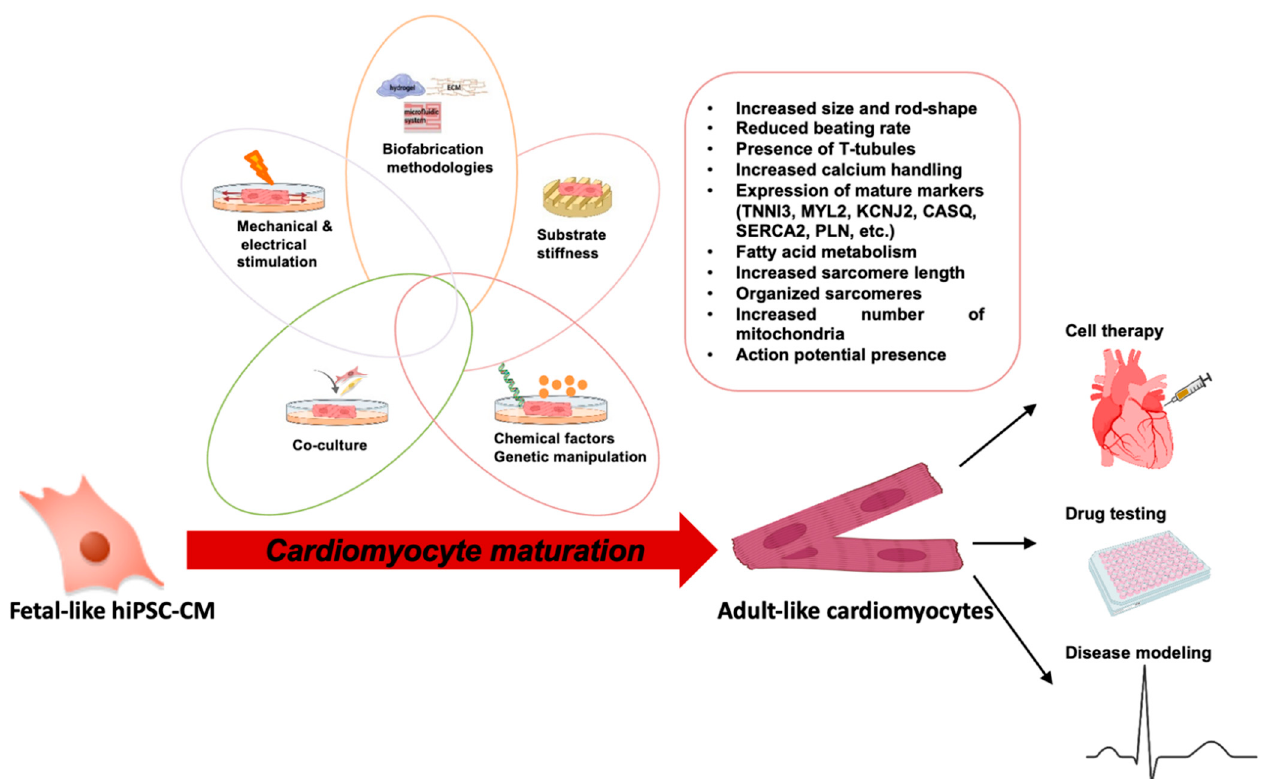
Figure 2. Strategies to increase maturation of hiPSC-CMs and their applications in basic research and in the clinical scenario. Electrical, mechanical, and biochemical factors, alongside genetic modifications and approaches aiming at adjusting substrate stiffness can be harnessed to enhance the maturation of hiPSC-CMs. Adult-like hiPSC-CMs are characterized by morphological, structural, genetic, and electrophysiological modifications.